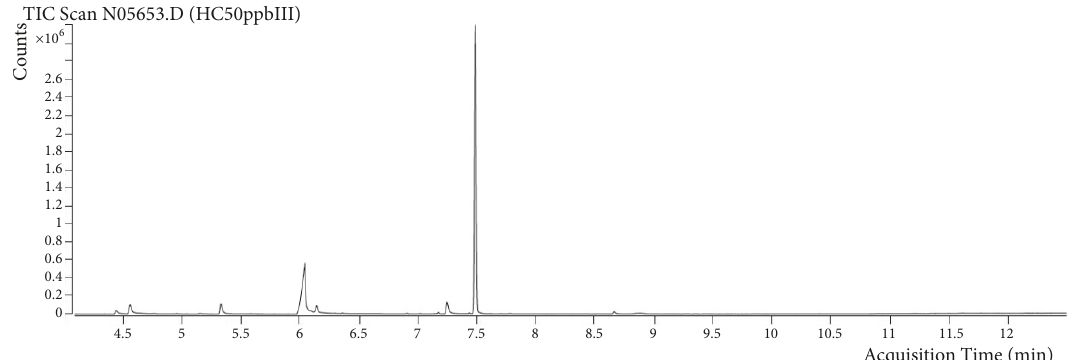
Figure 1: Example chromatogram for propofol (gaseous application; 50 ppb v ).